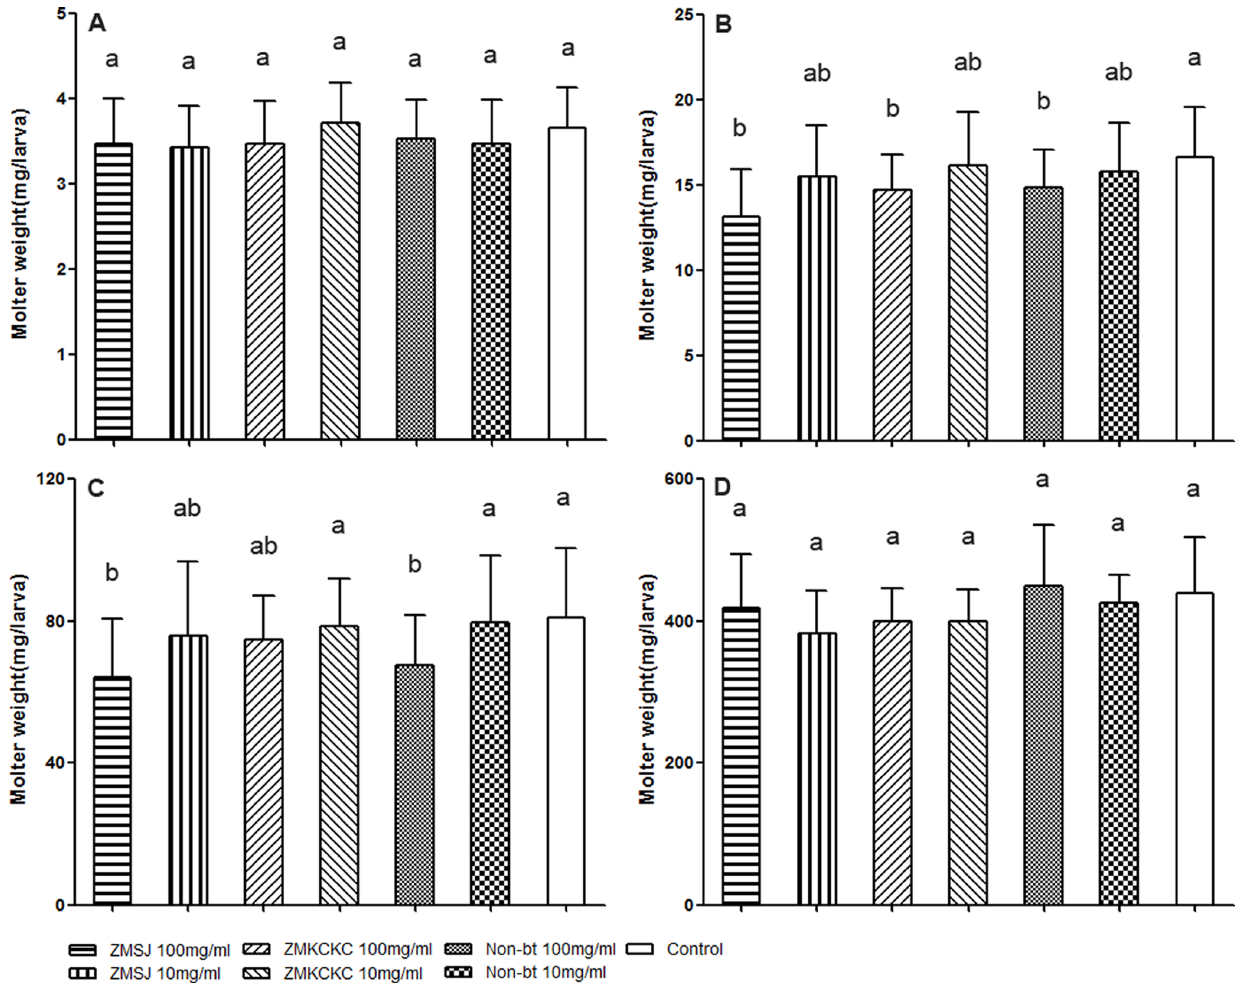
Figure 4. Weight of silkworm molters treated with different doses of Bt pollen or non-Bt pollen. A , D represents the molter weight of the 1 st to 4 th instar larvae. Values with the different letter are significantly different. Bars represent standard error. Levels of significance: P , 0.05 (ANOVA followed by Tukey’s post-hoc test).